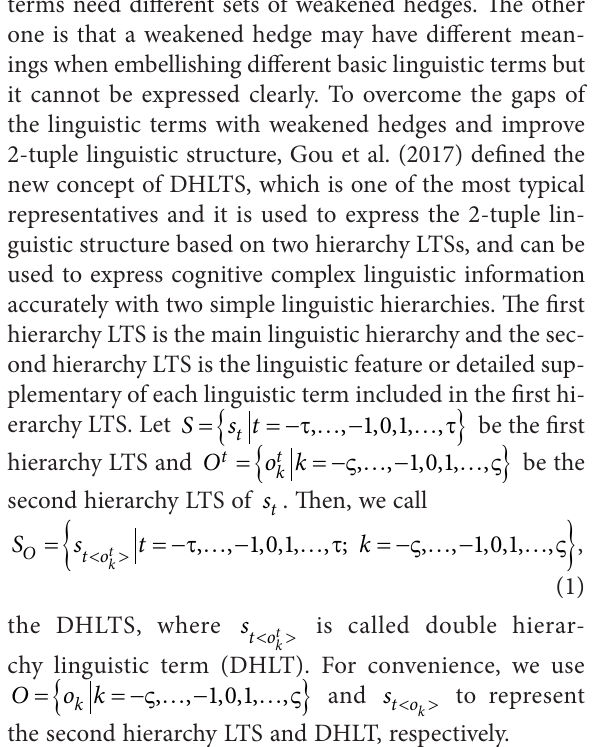
medium high very high perfectlowvery lownone